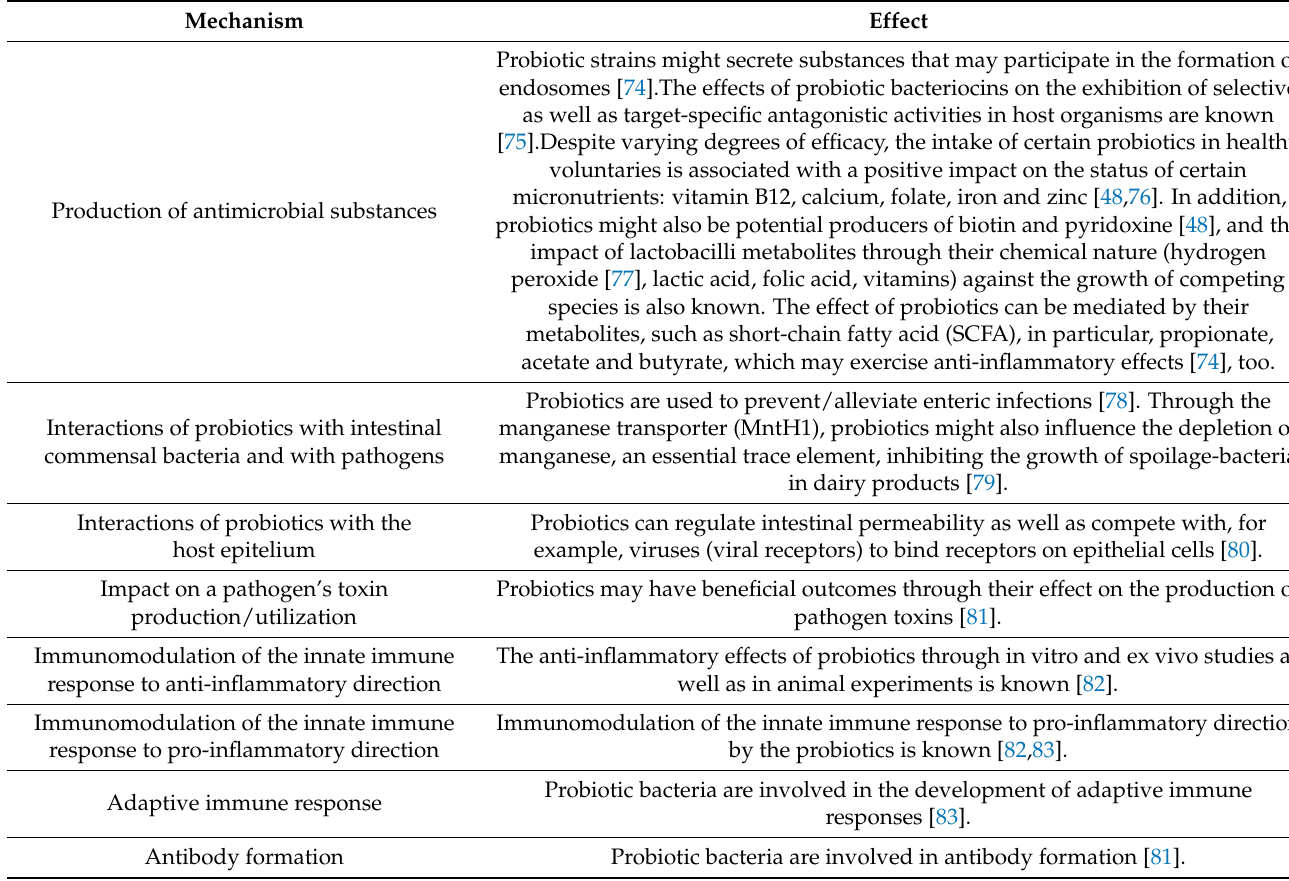
Table 1. Main mechanisms that determine the beneficial effects of human/animal